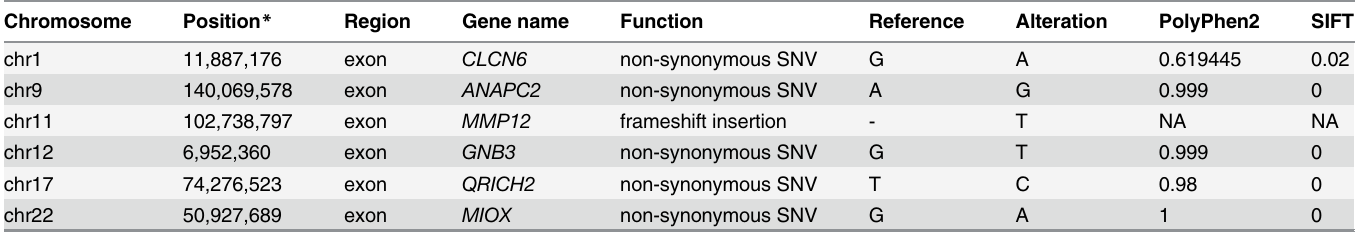
Table 1. Candidate genes selected by fi